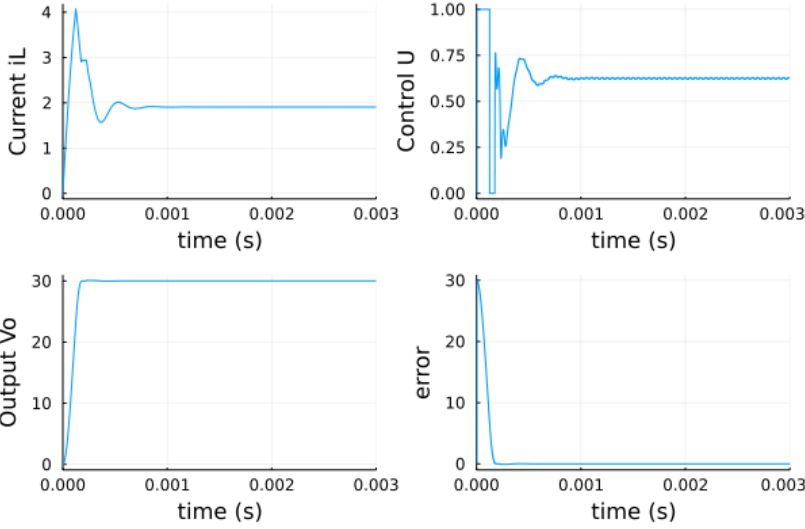
Figure 7. Output response of the Buck converter controlled by GAPID optimized by ABC: inductor current i L , output voltage V o , control signal U , and instant